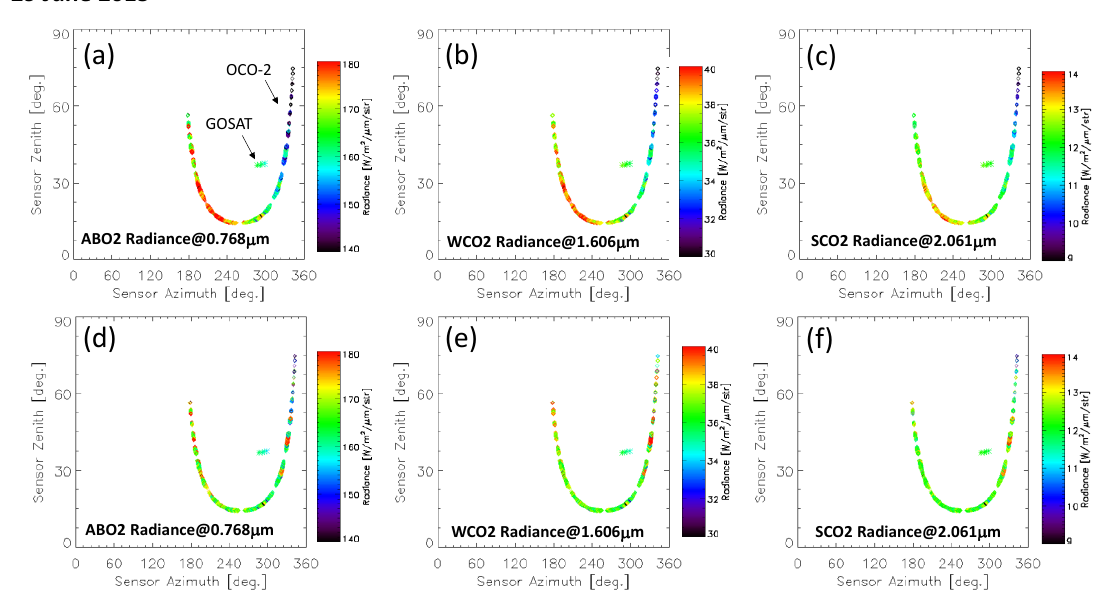
Figure 10. The OCO-2 and GOSAT spectra radiance against satellite azimuth and zenith angles during RRV target observations on 29 June 2015 at the wavelengths of ( a ) 0.768 µm in the ABO2 band; ( b ) 1.606 µm in the WCO2 band and ( c ) 2.061 µm on SCO2 band. The lower figures ( d – f ) represent BRDF corrected spectral radiance at the same wavelengths as the upper figures.